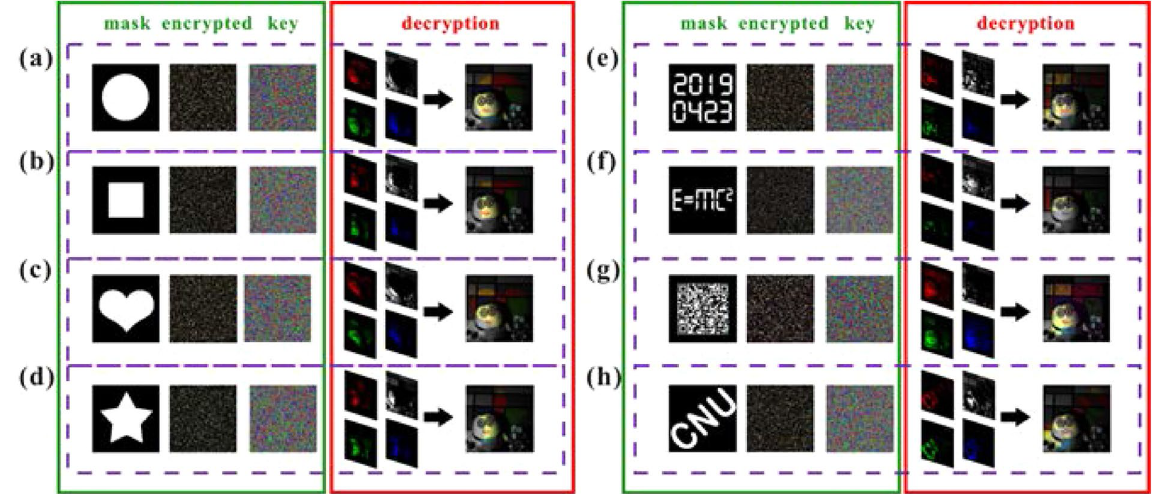
Figure 7. Imaging results for Experiment B. A total of eight sets of experimental results are presented. In the green solid line box are the mask templates, the encrypted imaging results, and the multi-color cipher patterns. The decryption is in the red solid line box. The three channels, which were linearly mapped into the SROI according to the cipher pattern and the gray-scale channel of other regions, finally produced the composite imaging